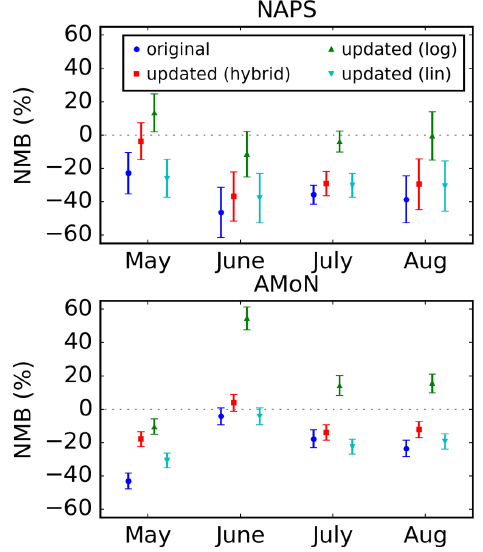
Figure 6. Normalized mean biases between the GEM-MACH am- monia surface fields and observations from the NAPS and AMoN networks for May to August 2016. In the legend, “original” and “updated” indicate the ammonia emissions used in GEM-MACH. The observation operator used in the inversion is indicated in the parentheses of the legend labels. Error bars denote the standard er-